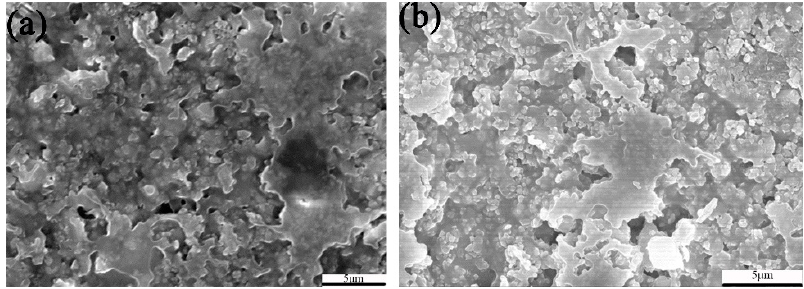
Figure 8. SEM images of two exterior paints respectively containing R-801 ( a ) and BLR-699 ( b ).